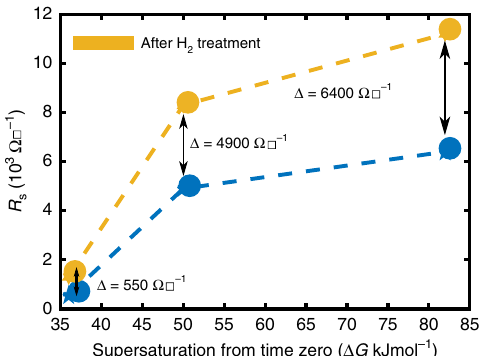
Fig. 5 Effect of grain size on sheet resistance change due to hydrogen treatment. R s of fi lms nucleated and grown at different supersaturations (See Supplementary Note 9 for effect of supersaturation on grain size) are shown in blue. R s obtained after a pure hydrogen anneal, or the lowest carbon potential exposure possible, are shown in yellow. Changes in sheet resistance are also marked. Sheet resistance and its change increase with a decrease in grain size, thereby proving that the responsible defects